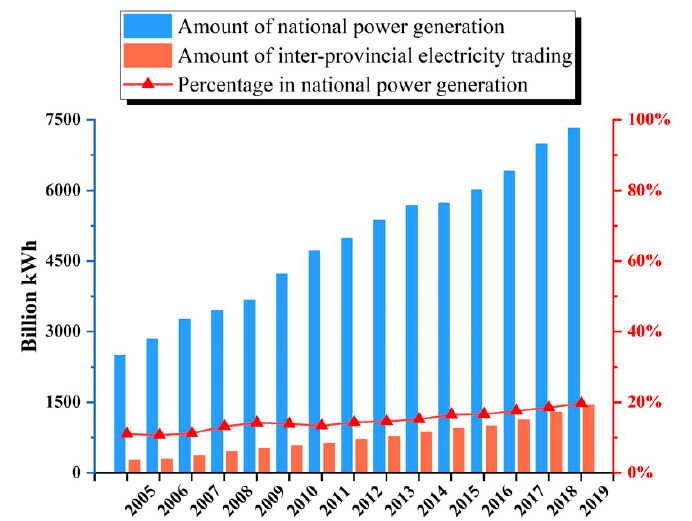
Figure 2. Total volume of inter-provincial electricity trading and national power generation in China between 2005 and 2019.